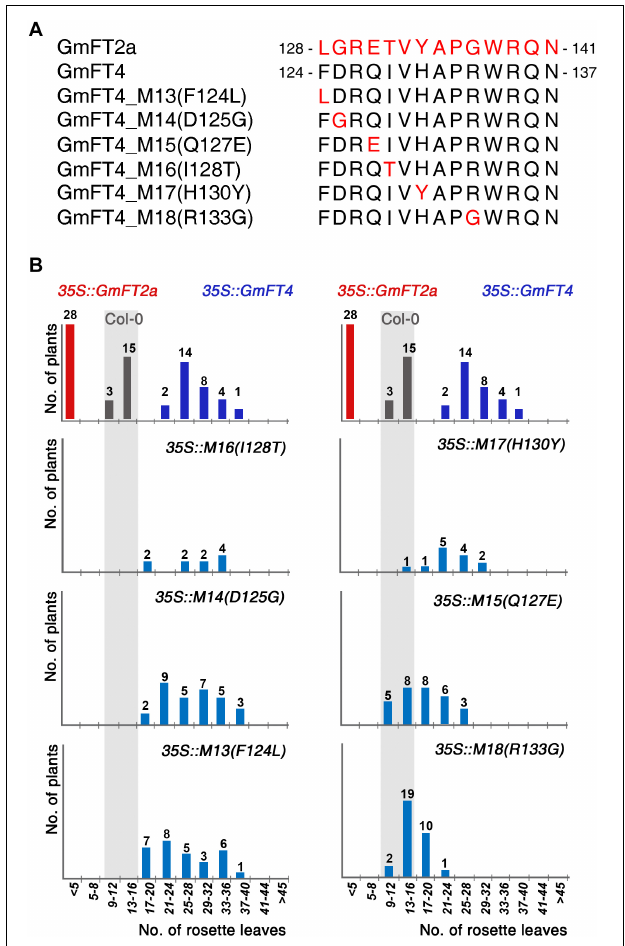
FIGURE 6 | Flowering phenotypes of transgenic Arabidopsis plants expressing the GmFT4 segment B-substitution mutants. (A) Amino acid sequences of the segment B regions of GmFT2a, GmFT4, and GmFT4 segment B-substitution mutants. The substituted amino acids of GmFT4 with corresponding amino acids of GmFT2a were indicated by red color. (B) Flowering times of GmFT4 segment B-substitution mutants. The distribution of flowering times in LD conditions for T1 transformants and control plants (Col-0) are indicated by vertical bars; gray, red, dark blue, and light blue bars for Col-0, 35S::GmFT2a, 35S::GmFT4, and the GmFT4 segment B-substitution mutants, respectively. The number of plants is indicated above each